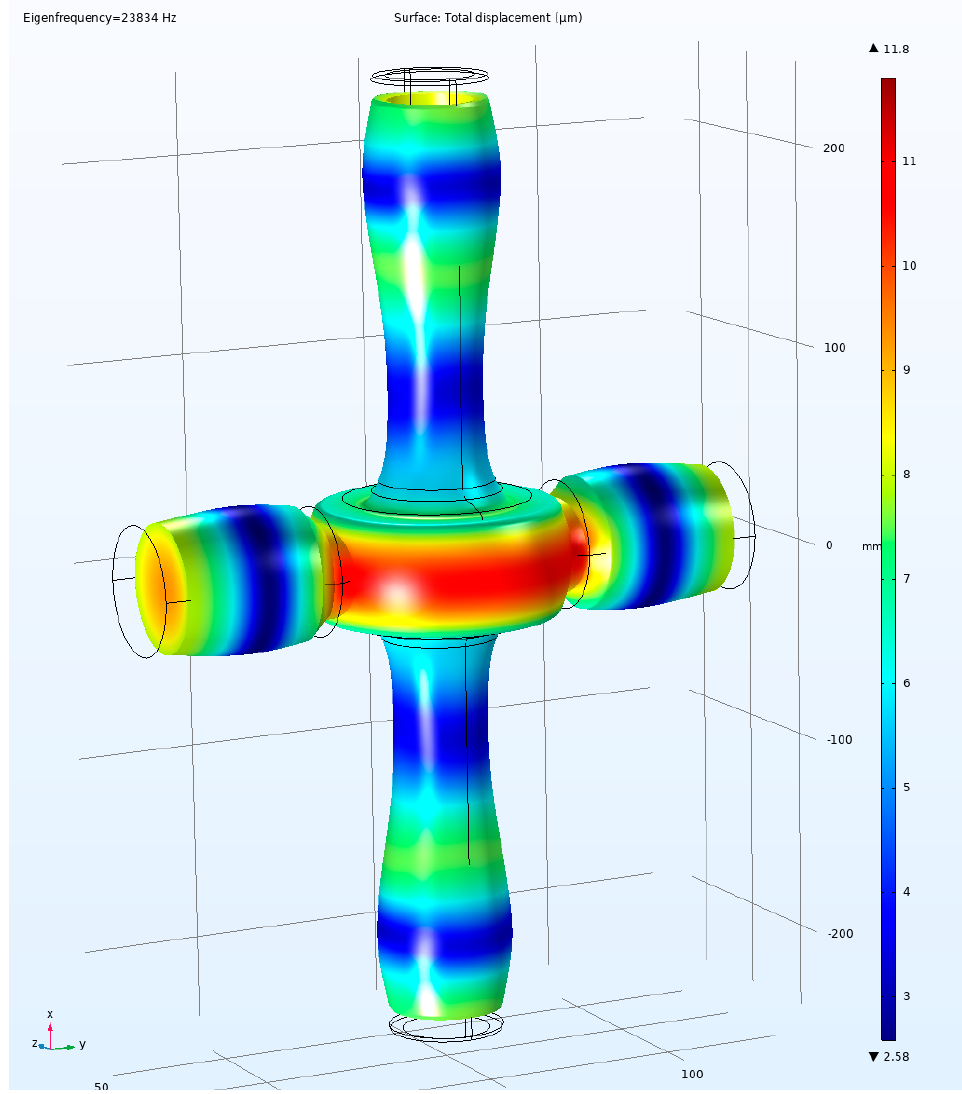
Figure 3. Visualization of the displacements (µm) in the reactor during operation. Based on the obtained data, a conclusion was made that, when taking into account the material, the optimal shape of the reactor is a cylinder with an internal diameter of 44 mm and an outer diameter of 58 mm. The maximum displacement of 12 µm was observed in the transformer zone. After determining the geometry of the reactor, a model of acoustic pressure distribution inside the reactor was built to assess the uniformity of the acoustic-wave distribution across the processed medium. The overall pressure distribution within the system was separately simulated. The model of pressure distribution during ultrasonic processing was built to avoid the formation of zones with pressures that are excessively higher than the average value. The calculation results are shown in Figure 4.